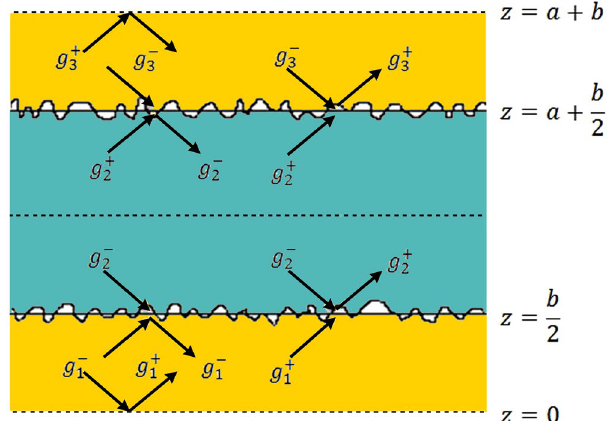
Figure 9. Diagram for the unit cell of a superlattice with rough interfaces and period d = a + b , where a and b are the thicknesses of the layers along the z direction. The symbols g correspond to the deviation functions from equilibrium for phonons propagating with wavevectors k z along the + z direction ( + ) and − z direction ( − ) in the three superlattice regions: (1) 0 < z < b /2, (2) b /2 < z < a + b /2, and (3) a + b /2 < z < a + b